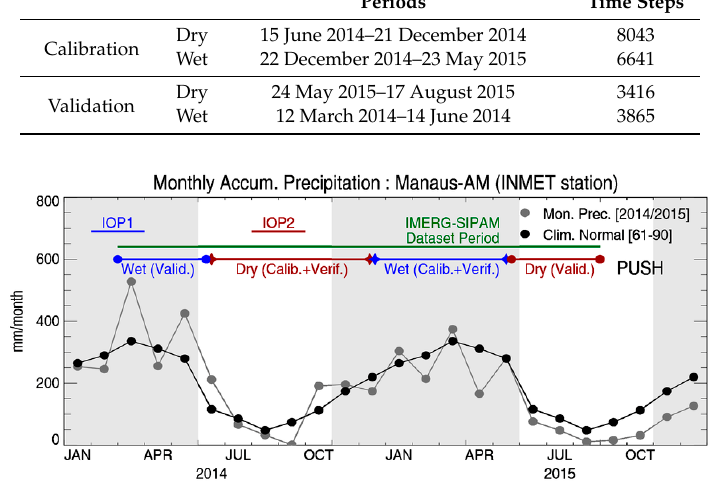
Figure 2. Precipitation regime over Manaus city (National Institute of Meteorology (INMET) station) and wet (blue) and dry (red) periods for PUSH calibration and validation. The shaded area represents the rainy season based on the Climatological Normal (1961–1990) shown with a black line. Wet and dry periods are based on the Liebmann and Marengo [19] criterion, which takes into account the actual observations (gray line). The CHUVA/GoAmazon IOP1 (wet) and IOP2 (dry) periods are also